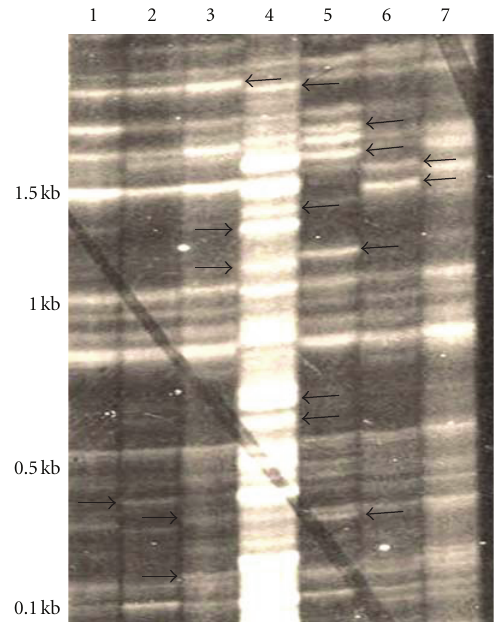
Figure 1: DALP-PCR amplicons obtained from rice and Leersia infesting populations of N. lugens using primer DALP235/DALPR (lanes 1–3 = rice infesting populations, lanes 5–7 = Leersia infesting populations; lane 4 = An out group, N. bakeri ). Polymorphic mark- ers showed in arrow